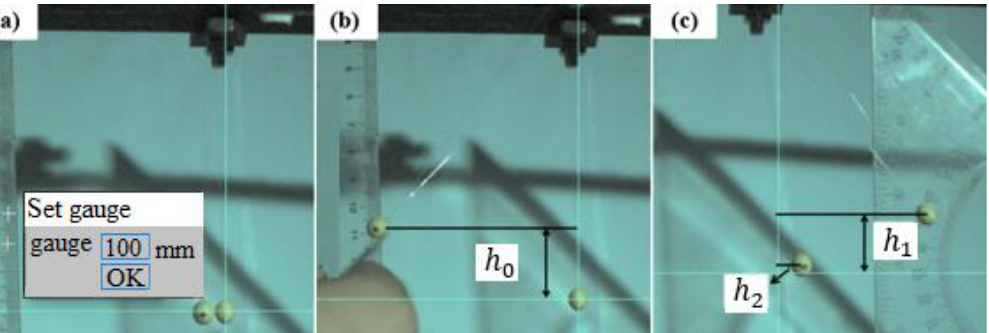
Figure 5. PCC image analysis process: ( a ) coordinate origin selection and distance calibration, ( b ) the vertical distance between the initial position of soybean seed particles and coordinate origin, ( c ) the distances between the highest point of the vertical rebound of the two soya beans and the origin of the coordinate after the first collision.